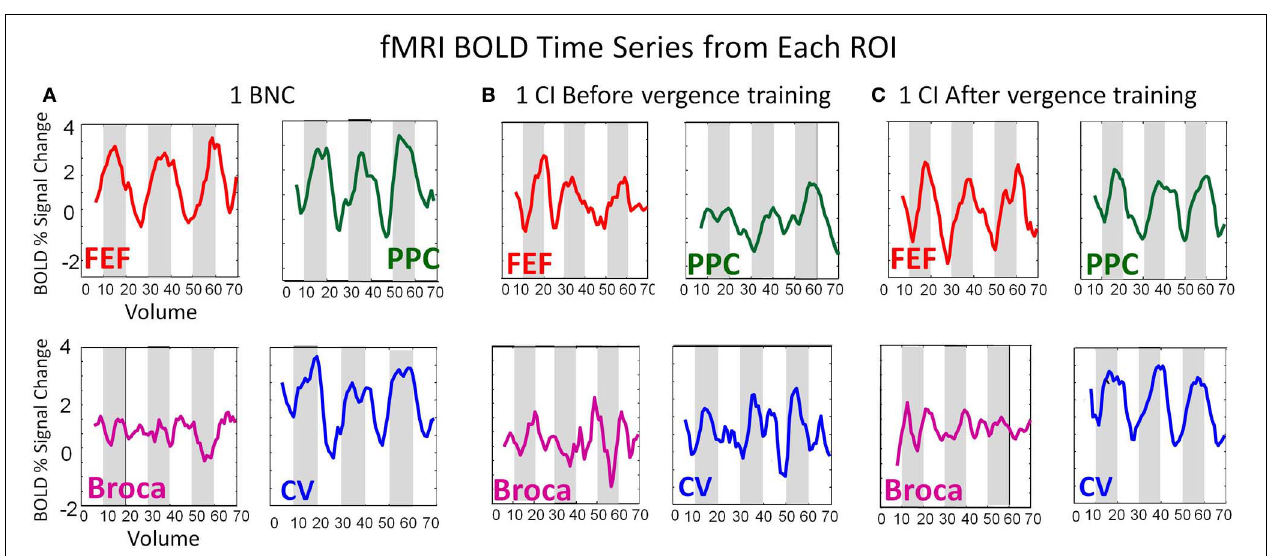
FIGURE 4 | BOLD time series from the FEF (red), PPC (green), Broca’s Region (Purple), and CV (blue) from a BNC (A), one CI before vergence training (B), and the same CI after vergence training (C).